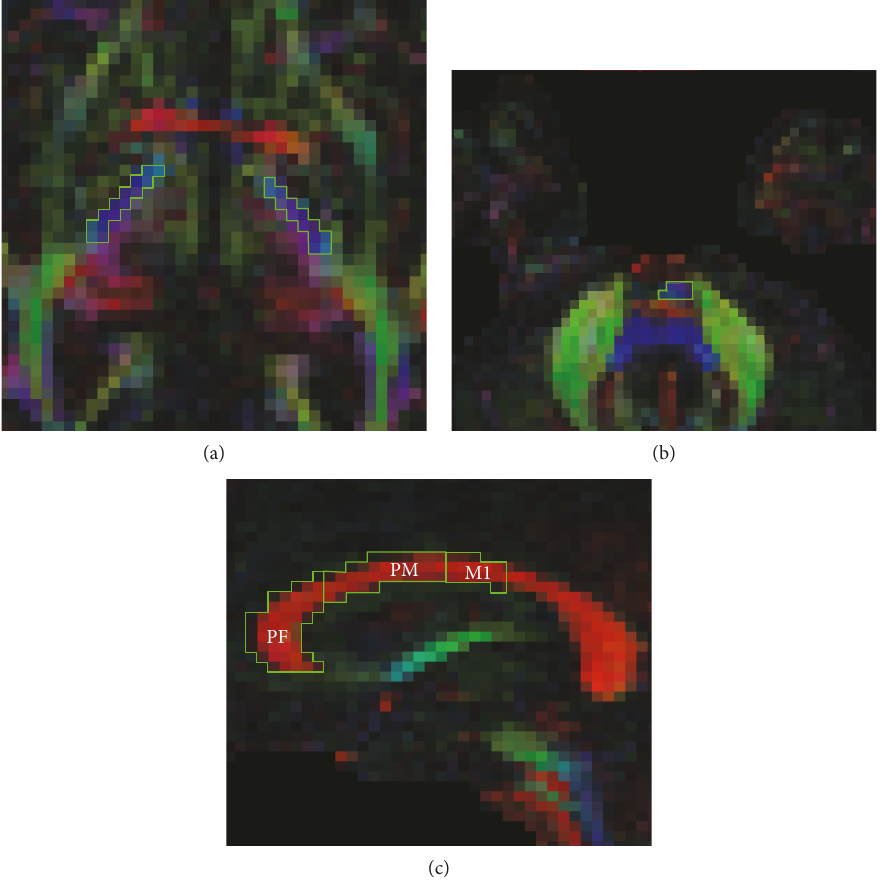
Figure 2: Representative regions of interest drawn on FA MAPS in ExploreDTI of an individual with severe arm impairment. Corticospinal tract regions of interest were drawn in the axial plane at the level of the (a) anterior commissure, and (b) pons as de fi ned by Mang et al. [10]. (c) Corpus callosum regions of interest were drawn in the midsagittal plane according to a geometric partitioning scheme for regions I, II, and III according to Hofer and Frahm